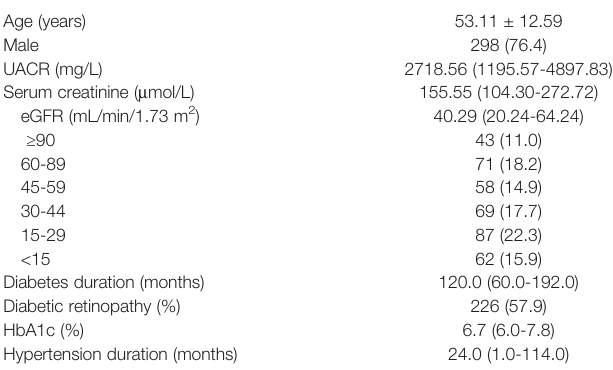
TABLE 1 | Clinical characteristics at the time of renal biopsy